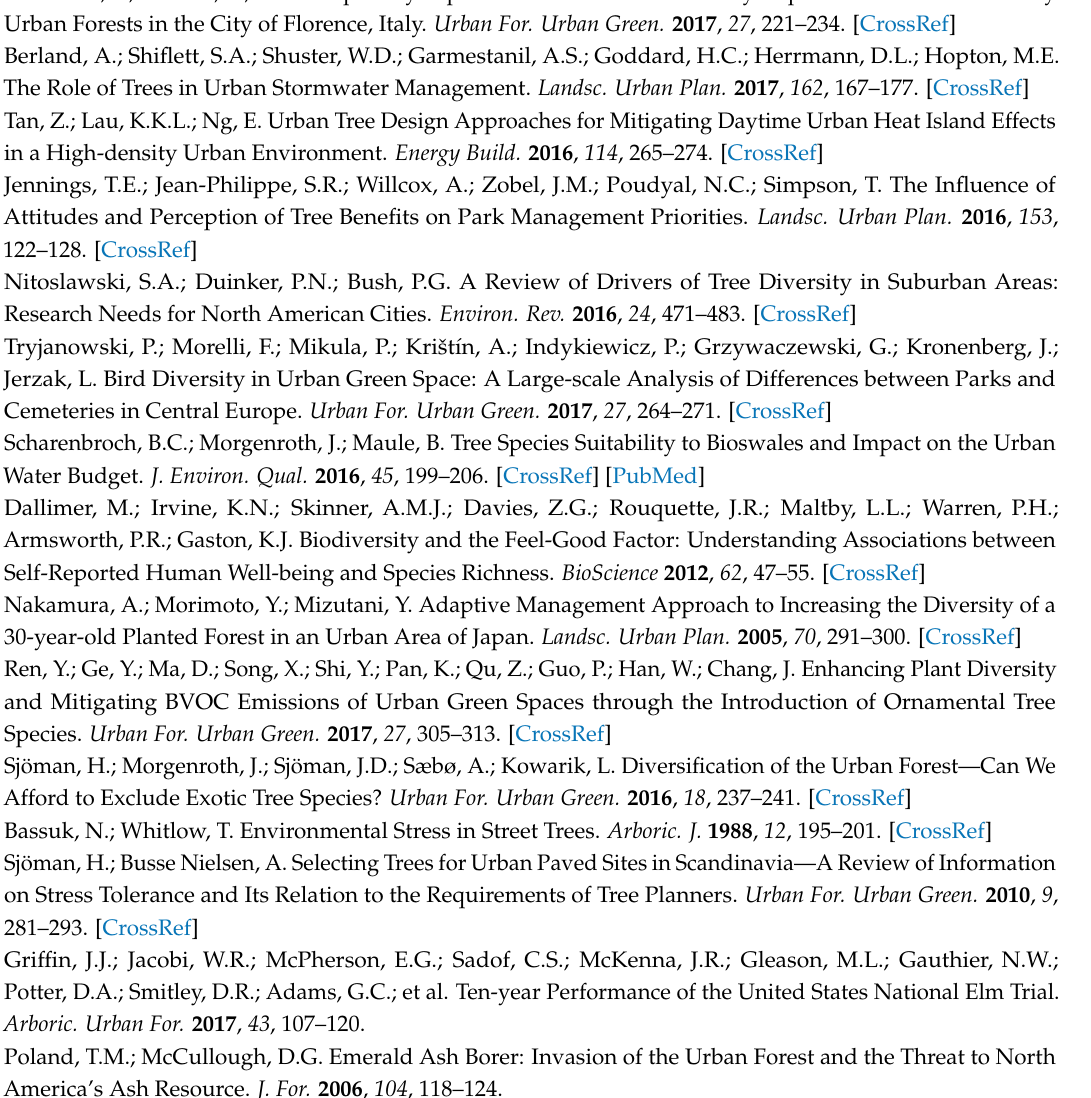
Table S5: Tree species affected by diseases and the level of severity of damage, Table S6: Tree species affected by pests and the level of severity of damage, and the data used in this